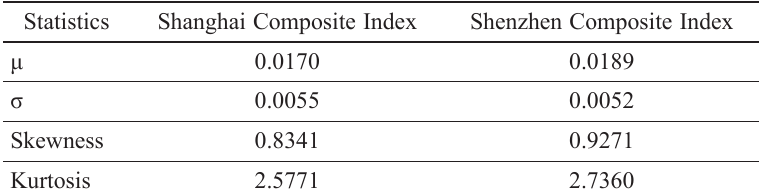
Table 1. The statistics of the GARCH volatility of the Shanghai and Shenzhen Composite Index returns, 2005–2012